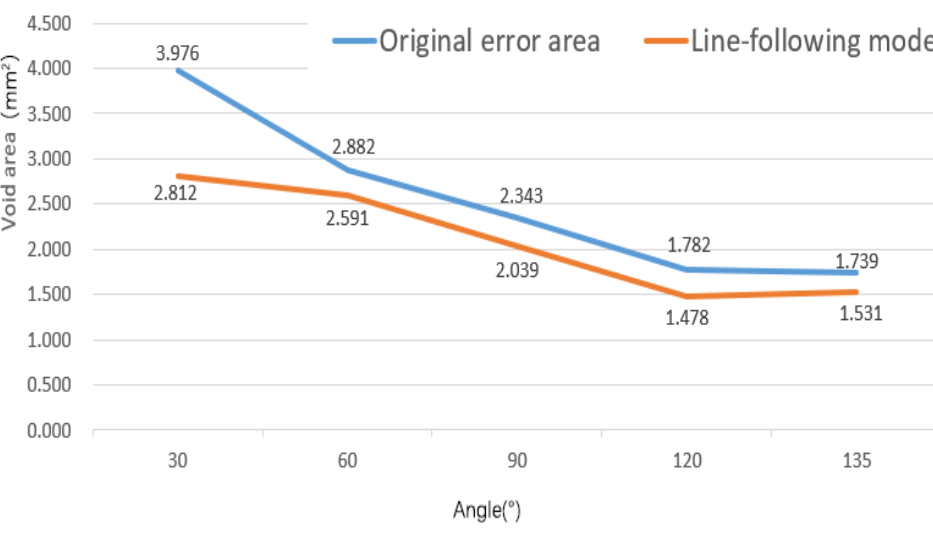
Figure 15. Void areas change with angles.